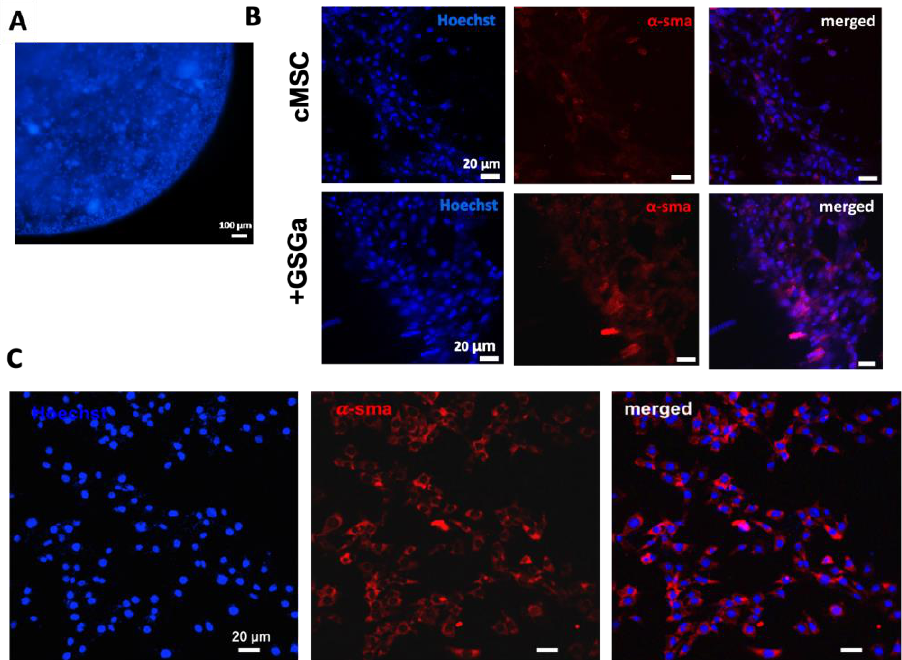
Figure 7. Effects of GSGa treatment of cMSC in 3D-PFHy culture systems on α-SMA. ( A ) Fluorescence micrograph of cMSC embedded in the PFHy microsphere (5 µL); after one week of growth, the nuclei were stained with Hoechst, using a protocol for staining of live cells. Scale bar is 100 µm; ( B ) cMSC embedded in PFHy (cMSC) and treated with GSGa (680 µg/mL) added to the culture medium (+GSGa) after seven days of growth. Z-stacks were obtained from the overlapping of 21 slices. Scale bars are 20 µm; ( C ) cMSC embedded in PFHy after 10 days of culture in complete medium containing 680 µ g/mL GSGa. Nuclei were in vivo stained with Hoechst dye, and α -SMA is shown in red. Scale bars represent 20 m.